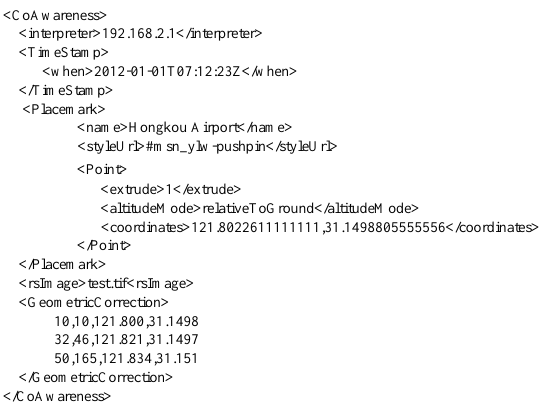
Figure 5. KML description of Collaboration awareness